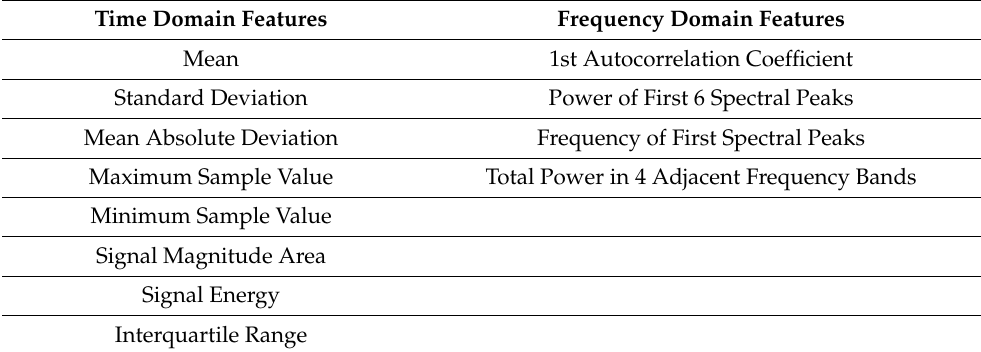
Table 1. Table of calculated time domain and frequency domain features for each